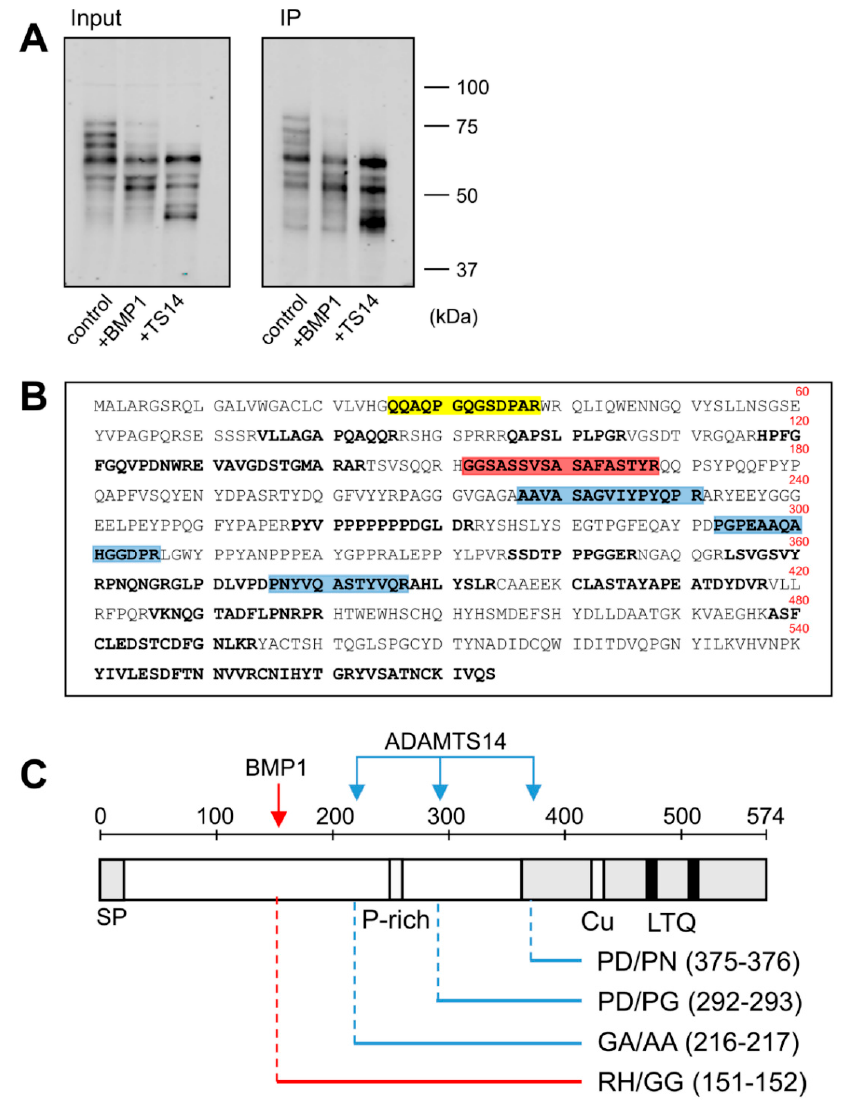
Figure 3. Proteomic characterization of the BMP1- and ADAMTS14-mediated cleavage sites in LOXL1 protein. LOXL1-GFP supernatants were exposed in vitro to BMP1 and ADAMTS14 for 2 h at 37 ◦ C and proteolytic products immunoprecipitated with GFP-Trap agarose beads. Aliquots from input and immunoprecipitated samples (IP) were analyzed by Western blotting with the anti-GFP antibody ( A ). The blots shown correspond to representative experiments performed twice with two independent preparations. IP products were then trypsin-digested, and the resulting peptides fractionated by liquid chromatography and analyzed by mass spectrometry. ( B ) Peptide coverage along the human LOXL1 sequence showing identified peptides (shown in bold). In addition to tryptic fragments resulting from the action of trypsin at both ends (K or R in P1), other peptides showed non-tryptic ends and resulted by the action of other proteases. Peptide marked in red showed a non-tryptic N-terminal end was more abundantly detected under BMP1 digestion, presumably representing the cleavage site by the BMP1 enzyme. Three peptides labeled in blue also showed non-tryptic N-terminal ends and were found upon digestion with ADAMTS14. Peptide in yellow with a non- tryptic N-terminal end corresponds to the mature LOXL1 protein after removal of the signal peptide. ( C ) Schematical representation of the cleavage sites by BMP1 (red arrow) and ADAMTS14 (blue arrows) within LOXL1 sequence with information about their positions and the residues involved in the